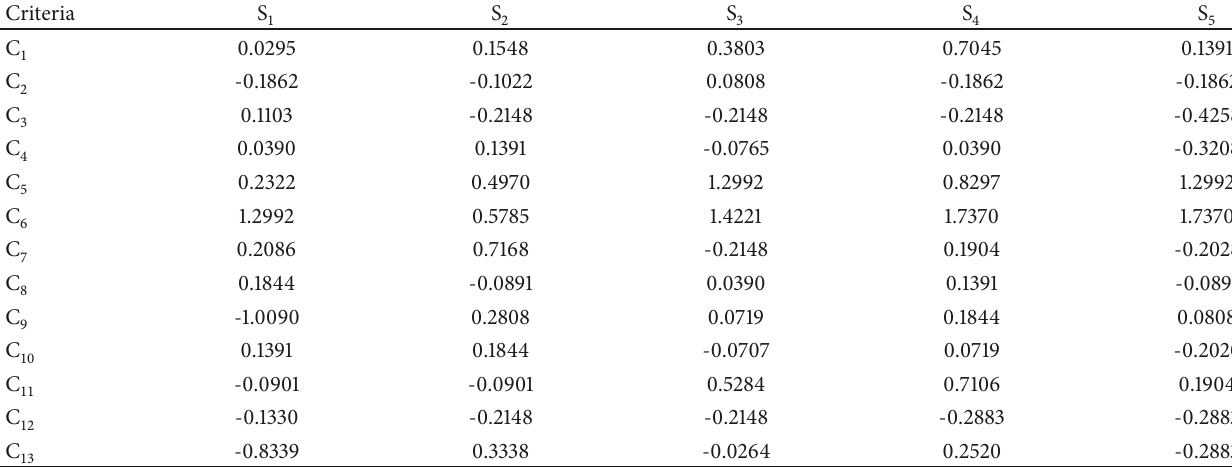
Table 13: Information contents of the criteria with respect to the maintenance